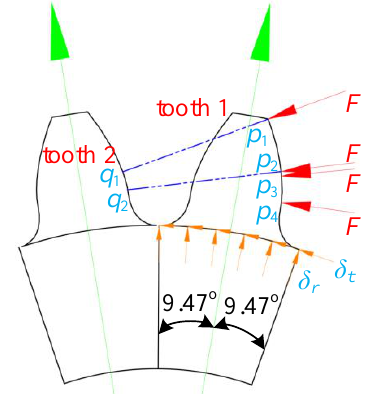
Figure 6. Forces applied on different locations of a tooth.